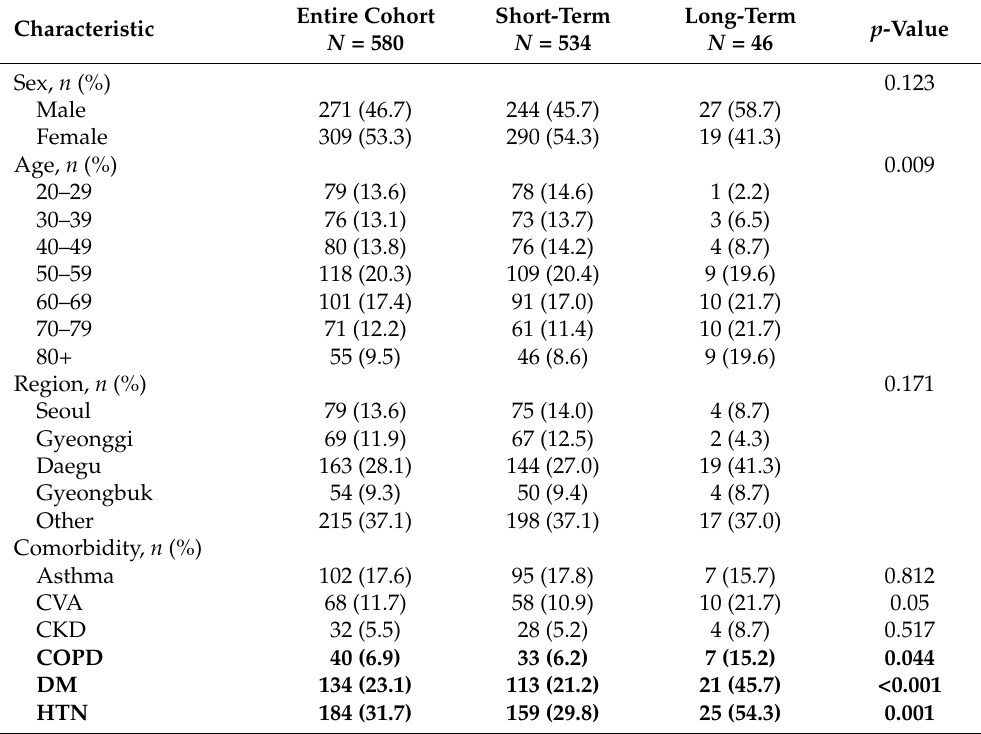
Table 1. Baseline characteristics of patients who were used non-steroidal anti-inflammatory drugs (NSAIDs) for short (2 weeks) or long term (8–12 weeks) duration before the COVID-19 index date in the Korean National Health Insurance System (NHIS) COVID-19